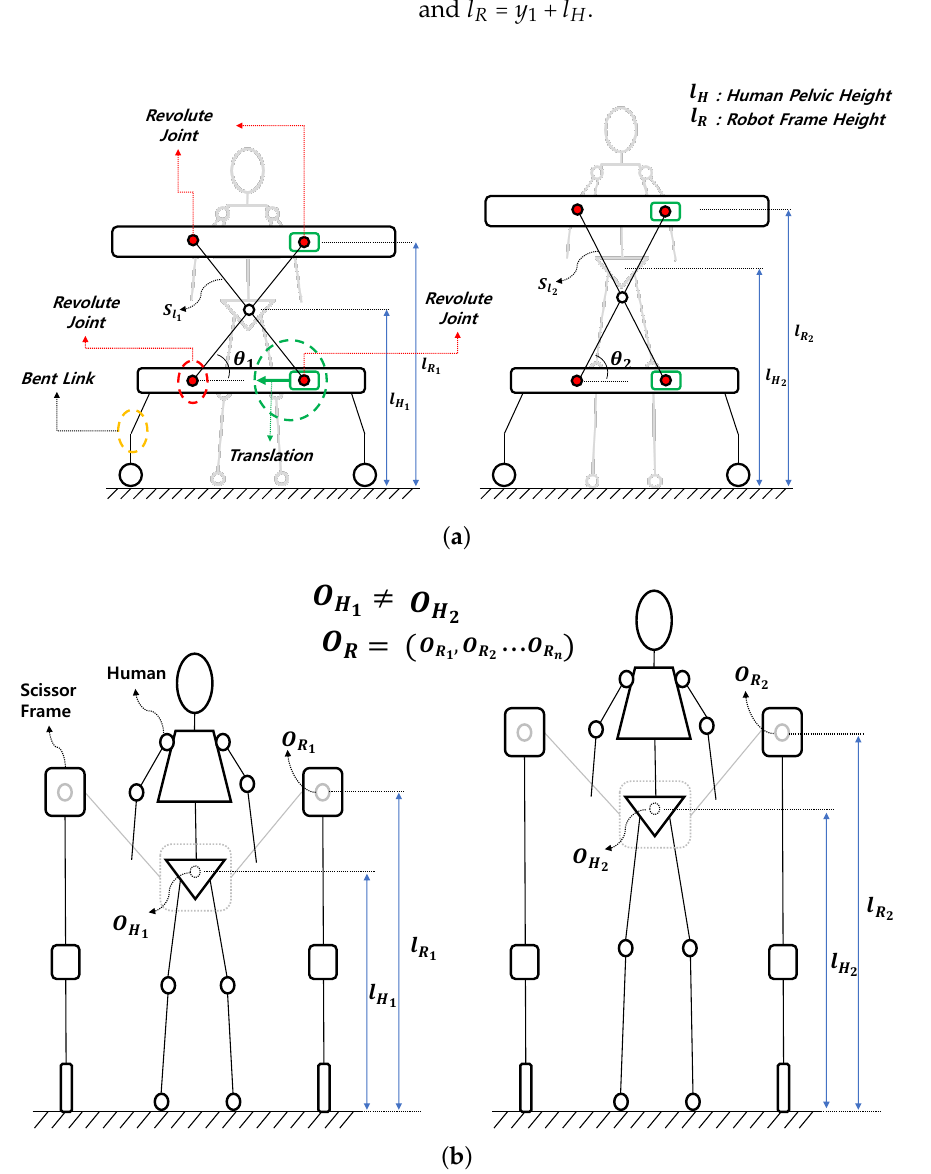
Figure 2. Conceptual design of the scissor mechanism. ( a ) The scissor mechanism’s conceptual design viewed from the side. Scissor mechanism connected with revolute joints (red circles) and two wheels with links supporting each systems’ weight (orange dottted circle). ( b ) Scissor mechanism’s conceptual design viewed from the front, which shows how our system can adjust to various human pelvis